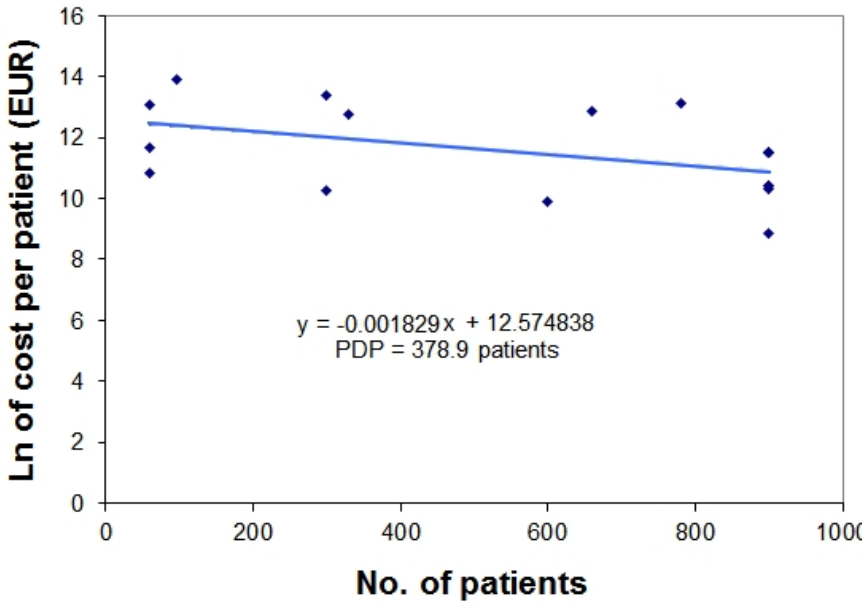
Figure 3. Price-vs.-patients relationship for a published data-set of 17 orphan drugs [2]. On the basis of 17 data pairs of price-vs.-patients (with log-transformed y-values), a linear regression is applied that identifies the linear regression equation shown in the graph. The slope of this equation is − 0.001829 patients − 1 ; hence, PDP is 378.9 patients. The numerical values of these 17 data pairs are reported in Appendix B along with information on the respective 17 orphan drugs.